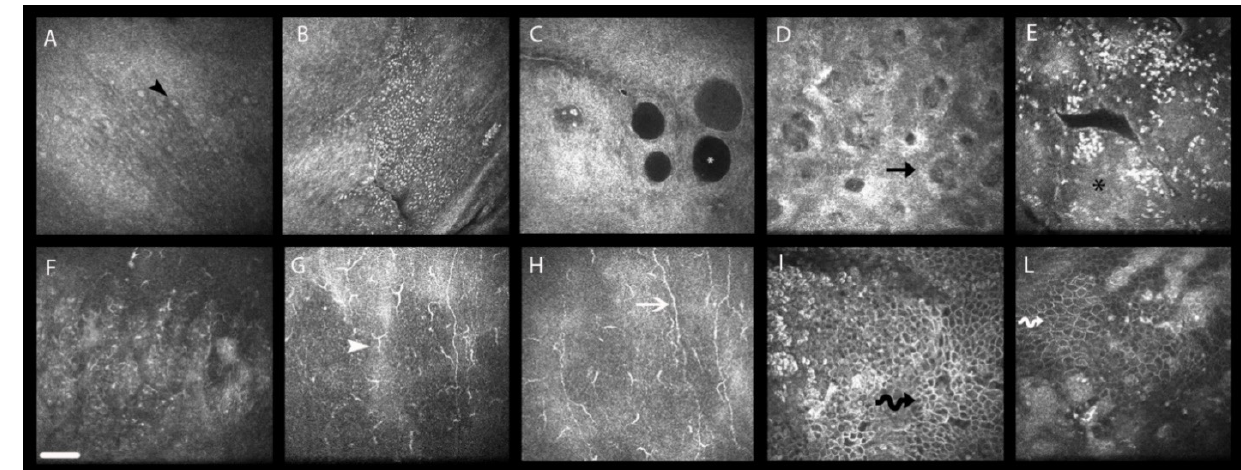
Figure 1. In vivo confocal microscopy (IVCM) of the ocular surface tissues in multi-treated medically controlled glaucoma. ( A – E ) Confocal frames taken from a patient controlled with a preserved fixed combination of timolol and dorzolamide and a preservative-free prostaglandin analog (PGA) (three eyedrops per day). ( A ) Goblet cells (GCs). GCs appear as hyper-reflective elements (black arrowhead) dispersed within the epithelium, and often appear scattered with an evident reduction of their density. ( B ) Inflammatory infiltrates. Inflammatory infiltrates appear as clusters of small hyper-reflective and mono-nucleate elements (presumably lymphocytes) infiltrating the epithelium of the tarsal or bulbar conjunctiva. ( C ) Epithelial microcysts. These structures (white asterisk) represent hallmarks of aqueous humor outflow stimulation through the uveo-scleral route, rather than detrimental effects induced by medications. ( D ) Meibomian glands. These glands appear markedly reduced in their dimension, with hyper-reflectivity of acinar wall and interstice; the black arrow indicates a glandular acinus. ( E ) CALT. Roundish immune follicles (black asterisk) appear infiltrated by numerous small hyper-reflective mono-nucleate cells (presumably lymphocytes). ( F – L ) Confocal frames taken from a patient controlled with a preserved fixed combination of timolol and dorzolamide, PGA, and brimonidine (five preserved eyedrops per day). ( F , L ) Limbal transition epithelium. The transition epithelium of the limbus appears irregular with scattered and highly hyper-reflective inflammatory elements ( L ), and with evident features of cellular polymegathism (undulated white arrow). ( G – I ) Cornea. The sub-epithelial layer and the Bowman’s membrane ( G , H ) present infiltration and activation of numerous dendritic cells (white arrowhead), with alterations of sub-basal nerve plexus morphology (white arrow). The corneal epithelium ( I ) appears markedly irregular with a higher degree of cellular polymorphism and polymegatysm. Bar represents 50 µm.